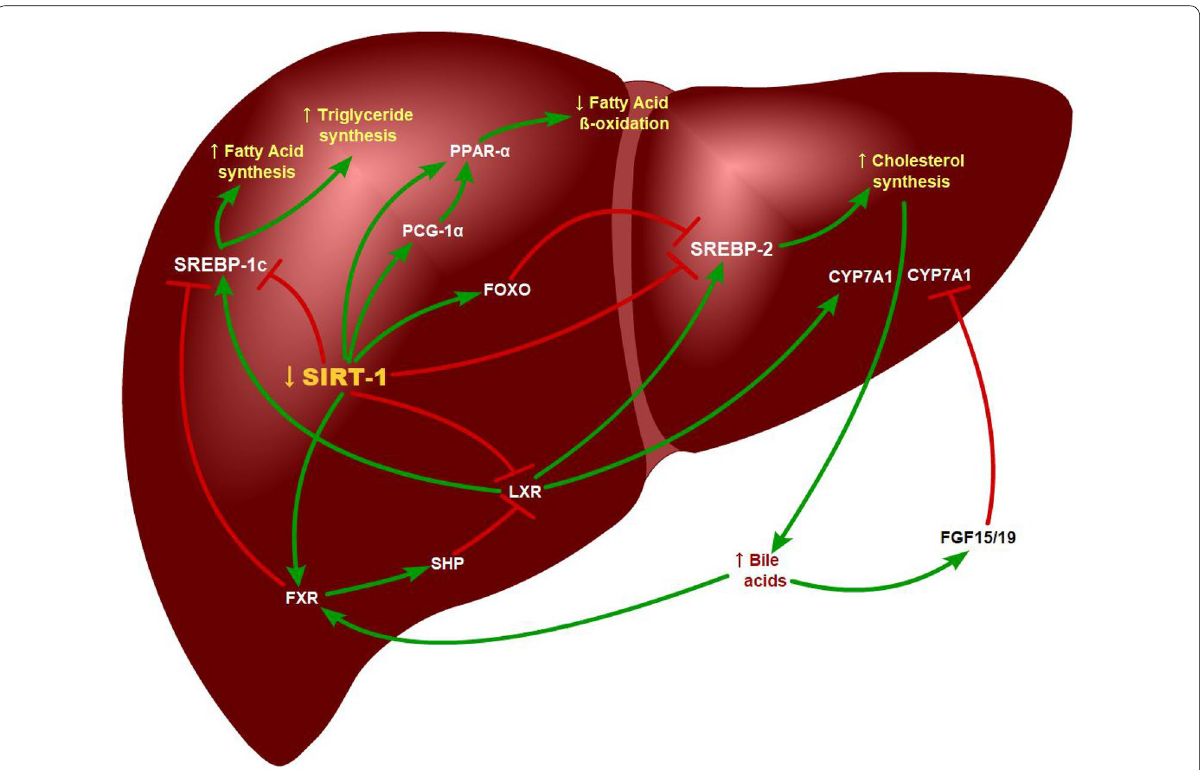
Fig. 1 The key pathways and target genes of the SIRT1 concerning cholesterol, fatty acids, bile acid, and triglyceride homeostasis. Decreased SIRT1 eventually promotes triglyceride, fatty acid, and cholesterol synthesis, whereas represses fatty acid beta-oxidation. As a result, the lipid profiles alter due to the SIRT1